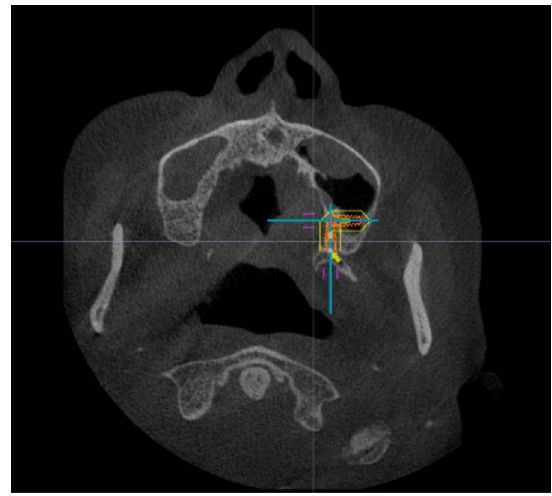
Fig. 4 A 10 mm implant parallel to the coronal plane from the top of the previous implant was made